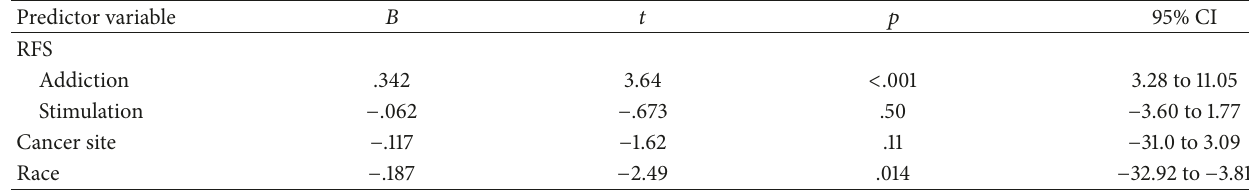
Table 3: Multiple regression analysis predicting number of cigarettes smoked one week before prequit visit.